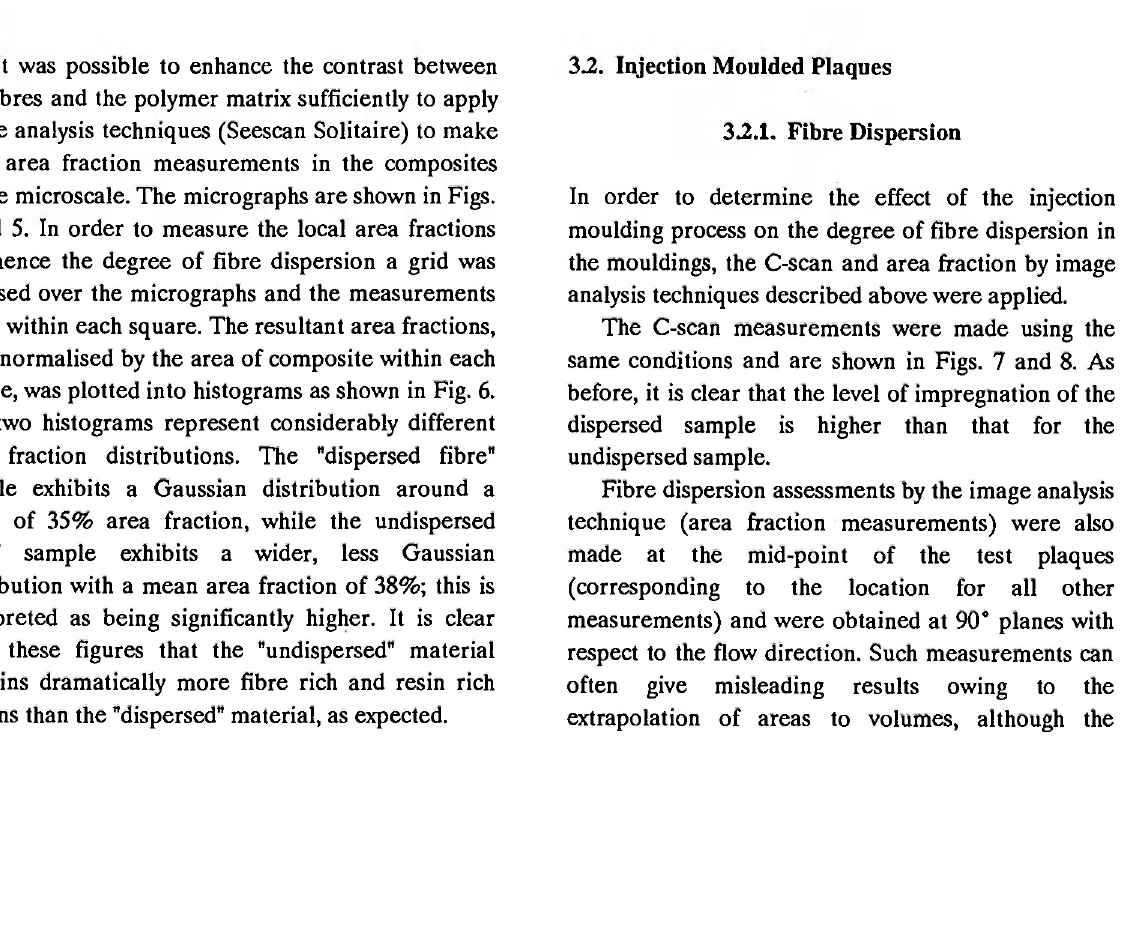
Fig. 3: Ultrasonic immersion C-scan plot for the "undispersed" compression moulded pultruded